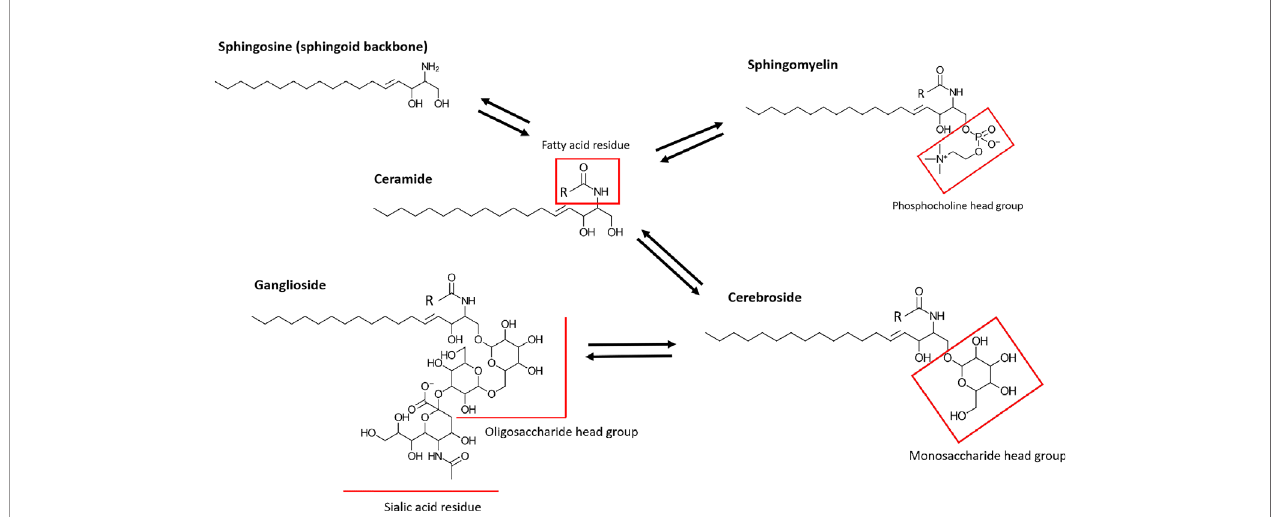
FIGURE 1 | Simpli fi ed structures of prominent human SLs. SLs consist of a sphingoid backbone, which is represented by Sph in this fi gure. By linking a fatty acid residue via an amide linkage, Cer (N-acylsphingosine) is formed. Cers differ depending on length and saturation of their alkyl chain on the fatty acid residue. The further addition of a head group, such as phosphocholine or phosphoethanolamine, to a Cer results in the formation of SM. More complex glycolsphingolipids are generated by addition of carbohydrate head groups. Neutral cerebrosides are formed by linkage with monosaccharide head groups. Linkage to oligosaccharide headgroups with one or more sialic acid residues forms